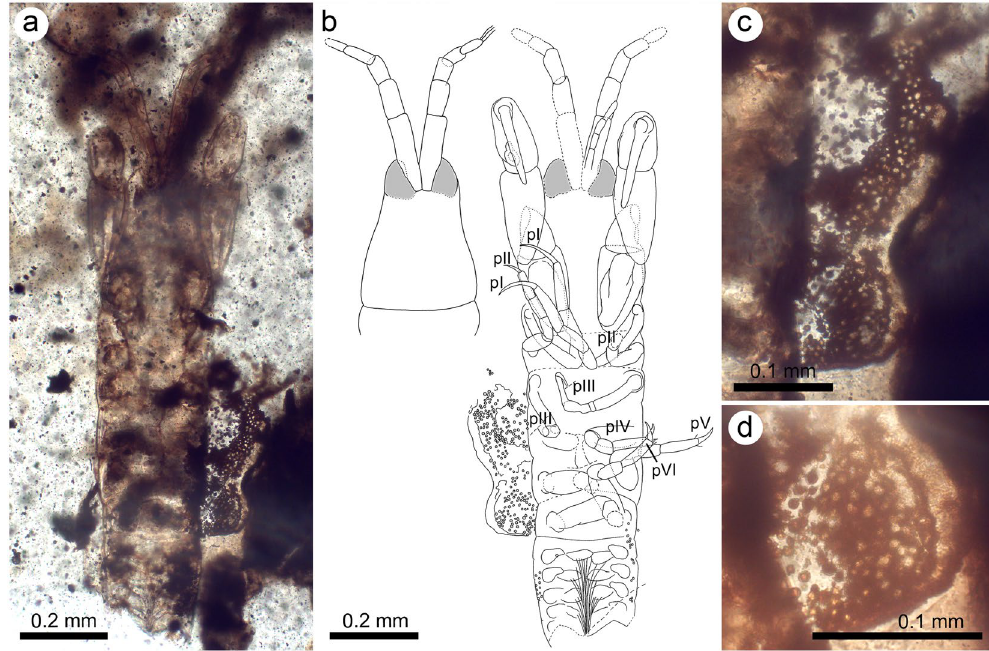
Figure 3. Holotype (IGR.BUZ-1.13), female, of Daenerytanais maieuticus gen. et sp. nov., from the mid- Cretaceous French amber of La Buzinie. ( a ) Dorsal habitus. ( b ) Camera lucida drawings of the cephalothorax in dorsal view (left), and the ventral habitus (right). ( c ) Detail of the marsupium. ( d ) Eggs. Abbreviations: pI– pVI = pereopods